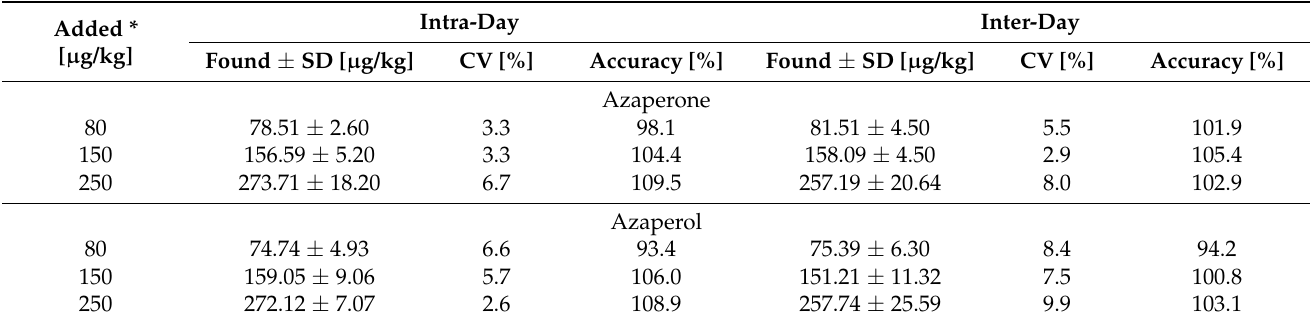
Table 3. Validation